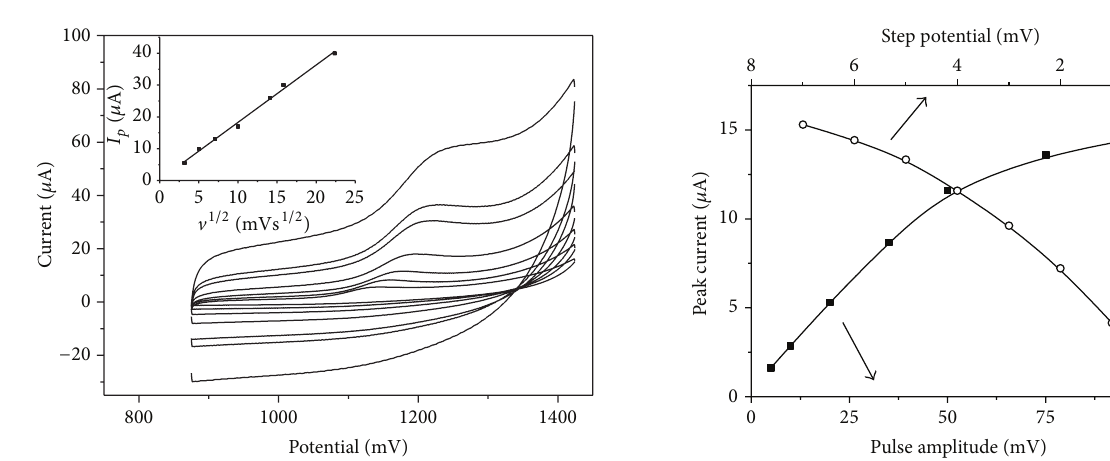
Figure 1: The cyclic voltammograms obtained for 50 𝜇 M codeine at the GC electrode modified with 10 𝜇 L Nafion/MWCNTs in 0.1M phosphate buffer (pH 3.0). Scan rate in the range from 10 to 500 mVs −1 (inner figure: dependence of the codeine peak current on square root of scan rate).